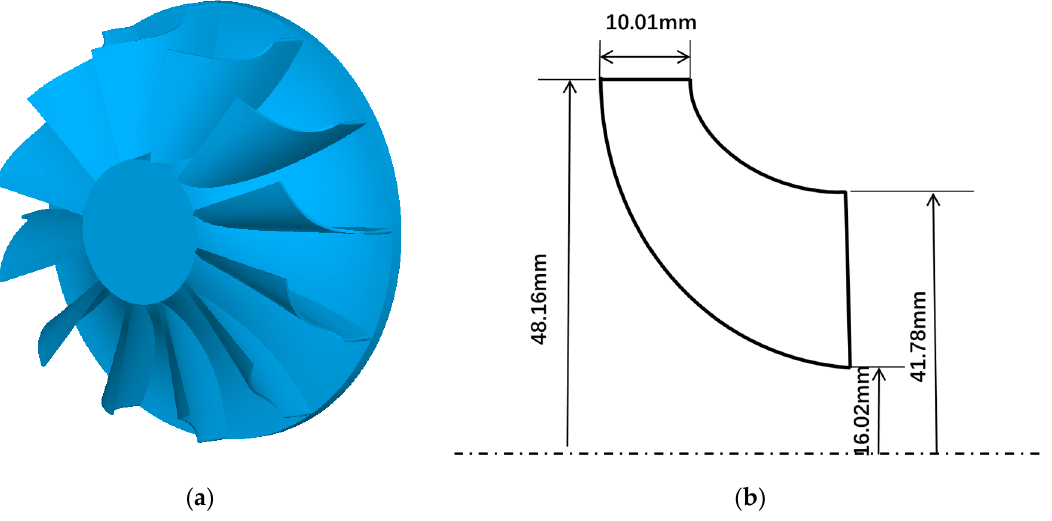
Figure 2. The 3D geometry and meridional cross-section of turbine. ( a ) The 3D geometry of turbine. ( b ) Meridional cross-section of turbine.